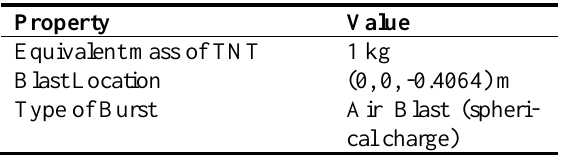
Table 1. Blast Load Input